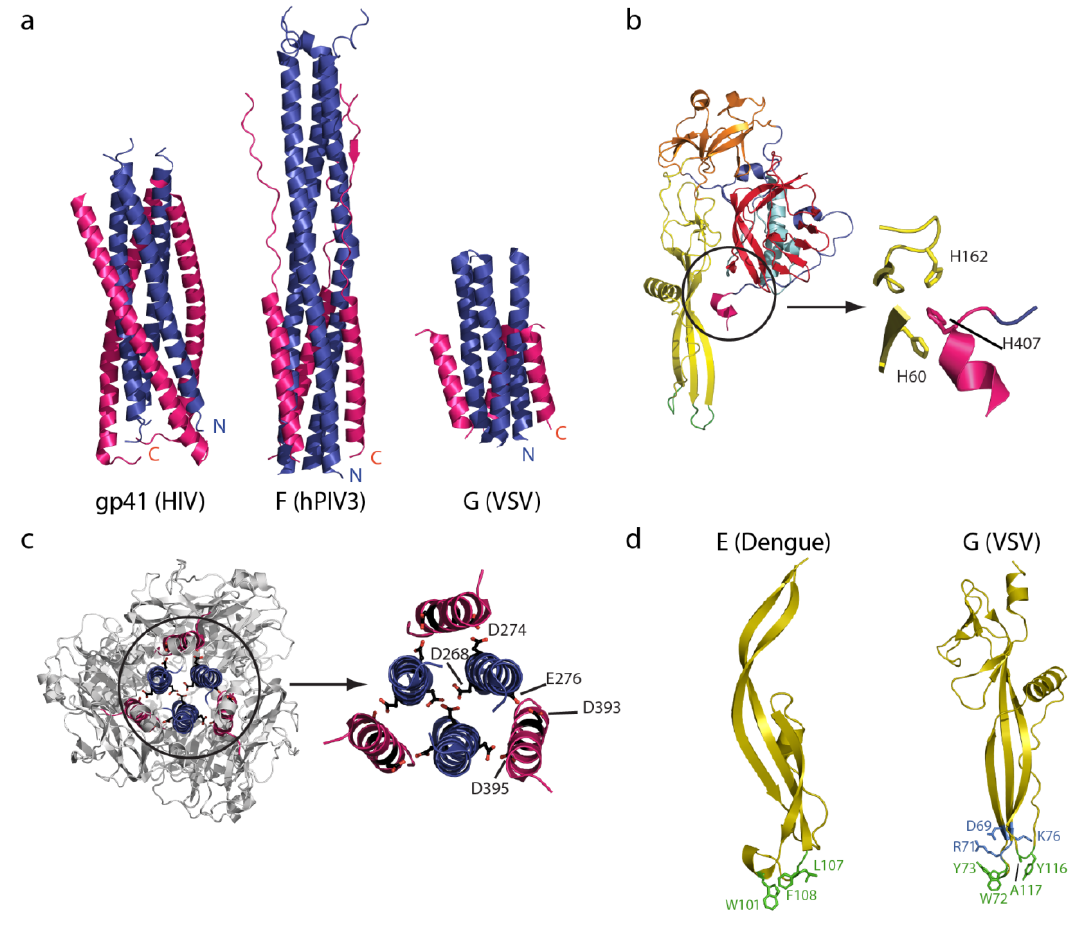
proteins (HIV gp41 and hPIV3 F) and class III viral fusion proteins (VSV G) in their post-fusion conformation. The amino-terminal trimeric coiled-coil is in blue and the antiparallel lateral helices are in pink. ( b ) A close up view of the histidine cluster located at the fusion domain/C-terminal domain interface that has to be disrupted during the structural transition from pre- to post fusion structure. ( c ) Top view and close up of the VSV G trimerization domain showing the clusters of acidic residues in the post-fusion state. ( d ) The structural organization of the Dengue virus E fusion domain (left) and the VSV G fusion domain (right). The hydrophobic residues in the tips of the fusion domains are depicted in green and, for VSV G, charged residues that impede deep penetration of the fusion domain inside the membrane are in